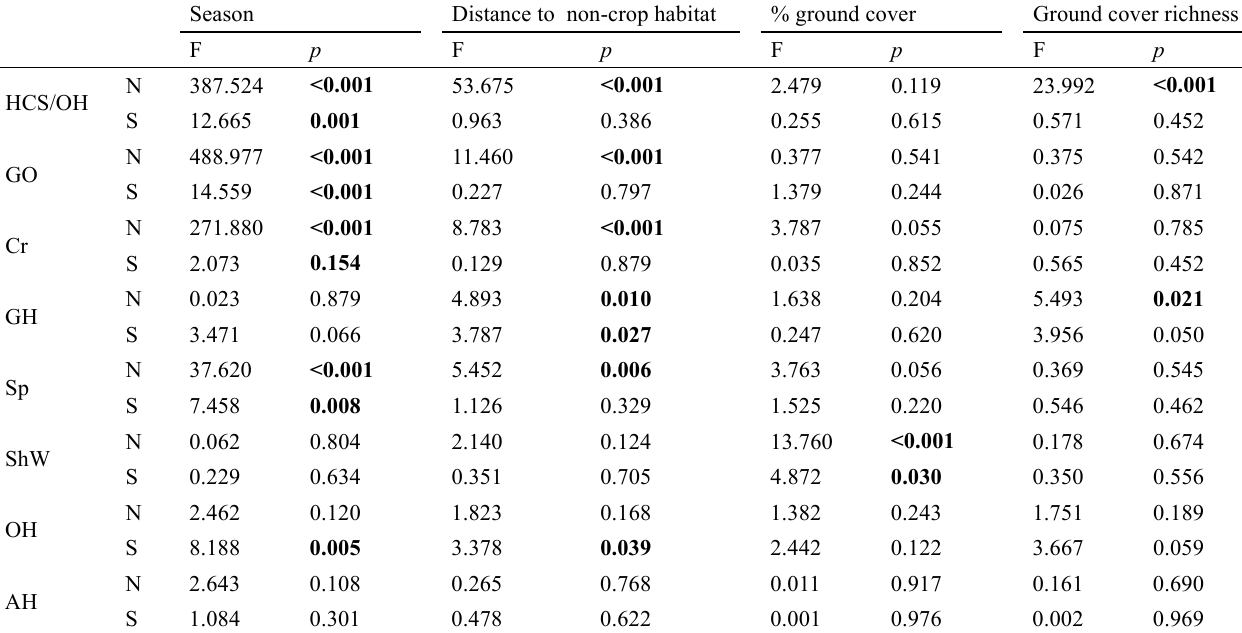
Table 4. Generalized linear mixed model (GLMM) analysis for main functional groups of spiders and ants captured in pitfall traps evaluating the impact of season (spring and summer), distance from adjacent vegetation (5, 50 and 100 m), and richness and percentage of ground cover in their abundance (N) and richness (S). GH - ground hunters; Sp - specialists; ShW - sheet web weavers; OH - other hunters; AH -